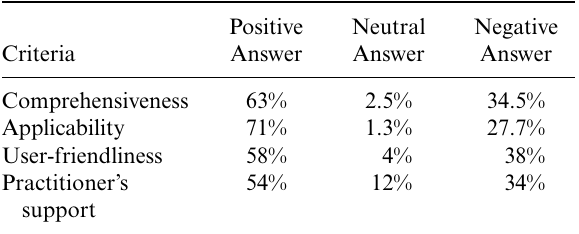
Table 10. Results of questionnaire responses